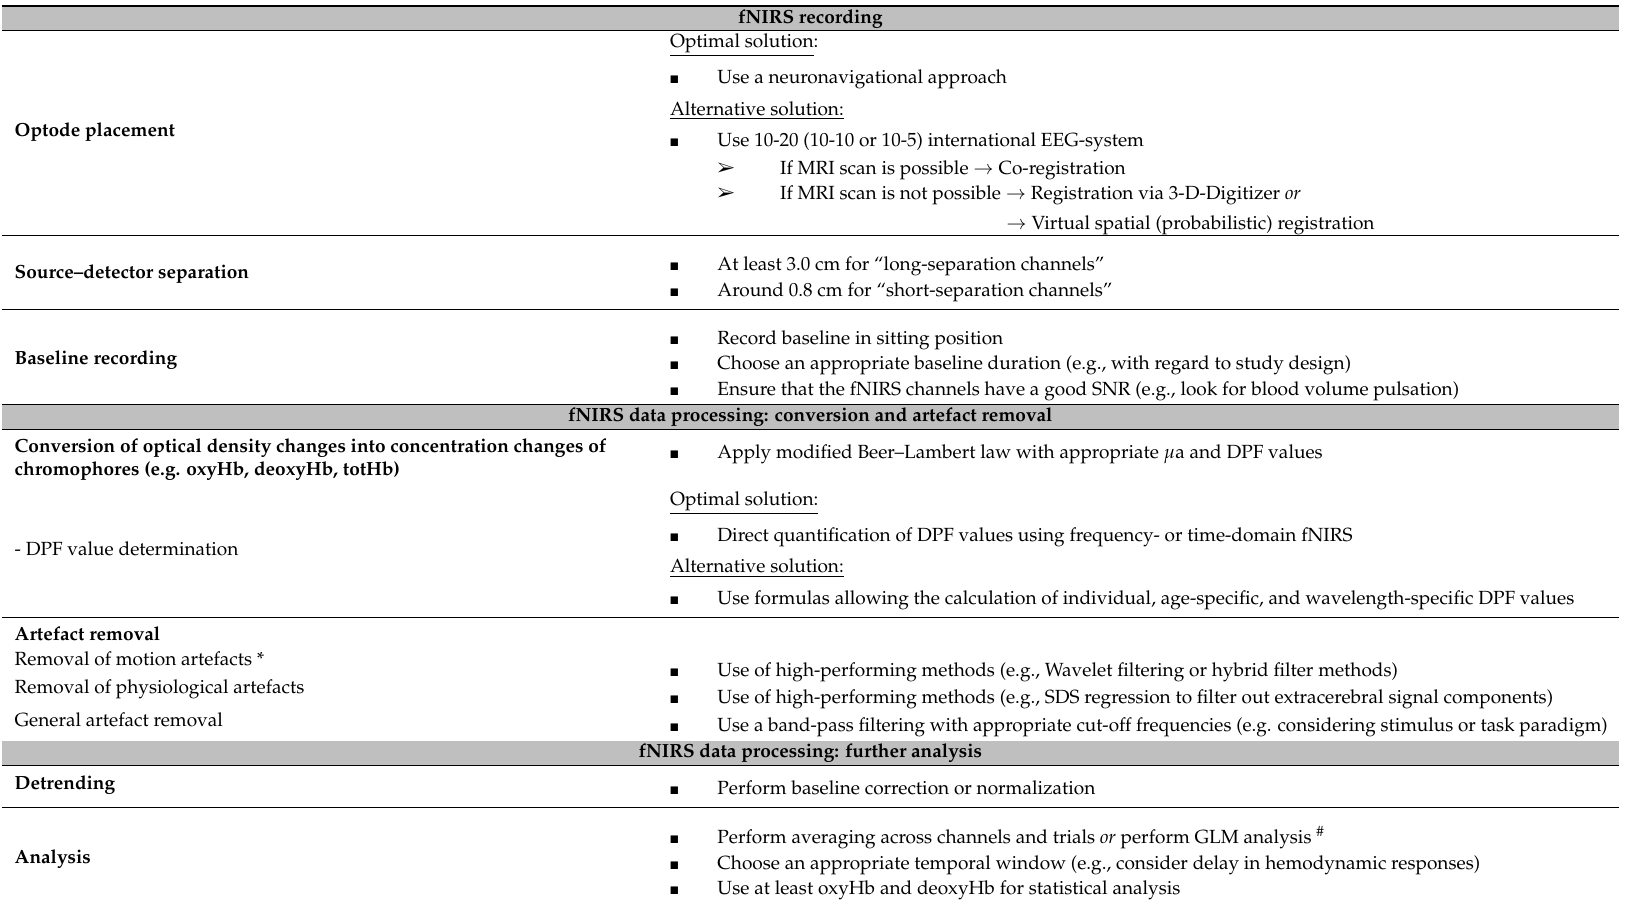
Table 2. Recommendations for fNIRS application, fNIRS data processing and fNIRS data analysis fNIRS